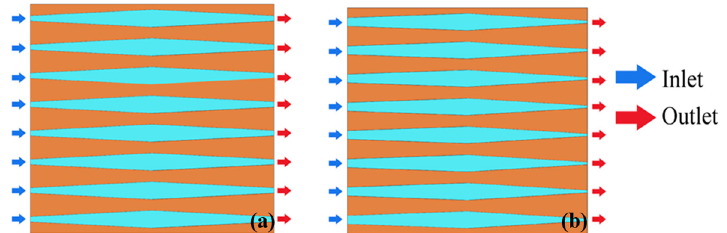
Figure 5. Microchannels with section width [91]: ( a ) symmetrical DCMCHCS; ( b ) asymmetric DCM- CHCS.